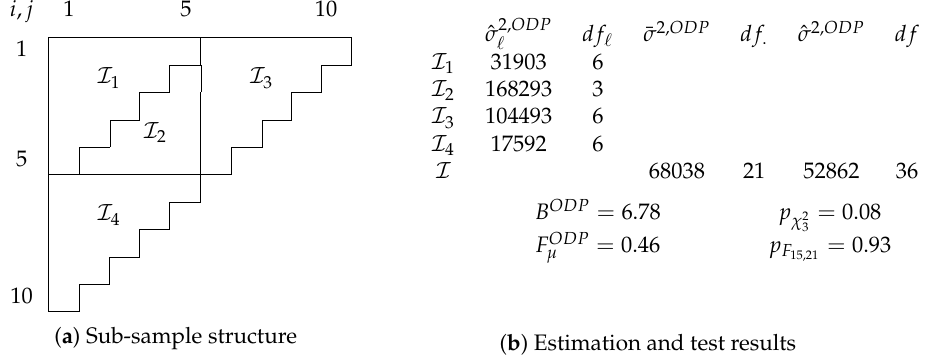
Figure 3. Over-dispersed Poisson chain-ladder model for Taylor and Ashe (1983) data. Sub-sample structure shown in ( a ), estimation and test results in ( b